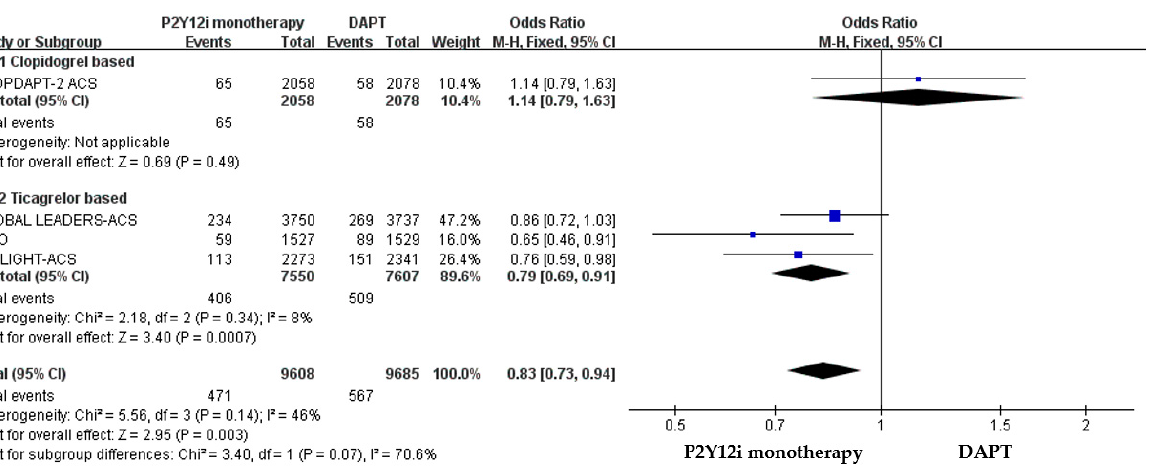
Figure 5. The NACE of different P2Y12 inhibitor monotherapy as compared with 12-month DAPT in patients with ACS after PCI.